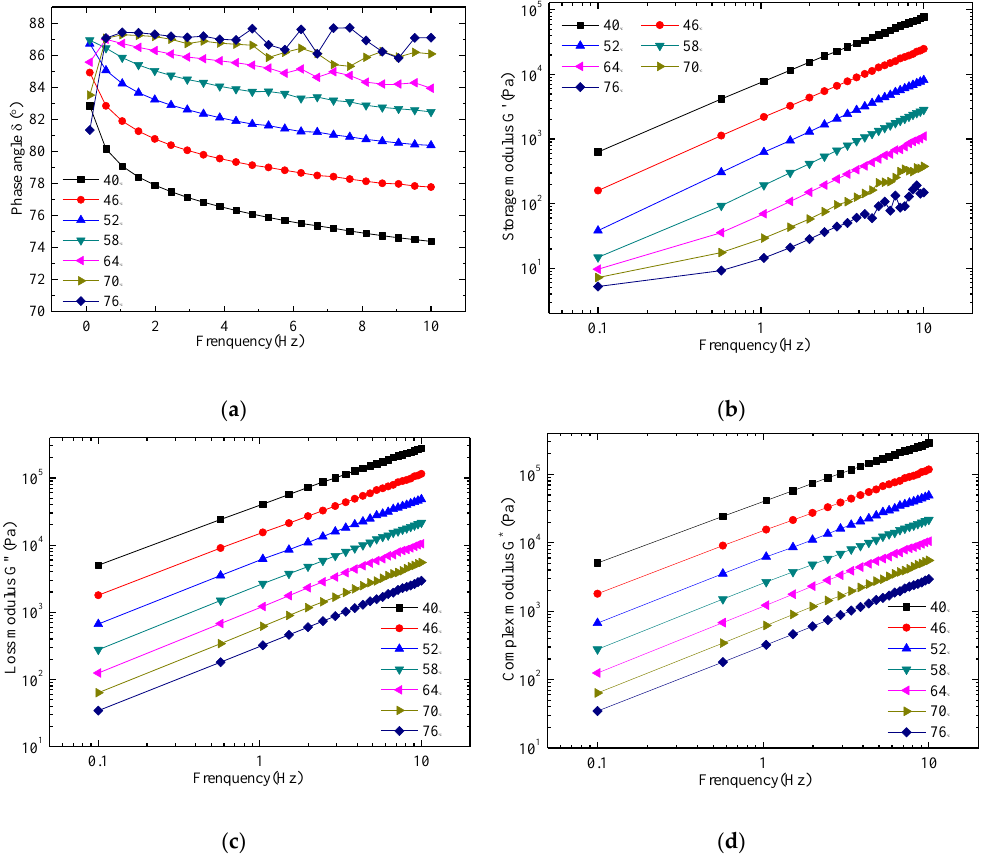
Figure 11. The changes of different parameters of unaged bio-asphalt with 5% content bio-oil. ( a ) Phase angle; ( b ) Storage modulus; ( c ) Loss modulus; ( d ) Complex modulus.